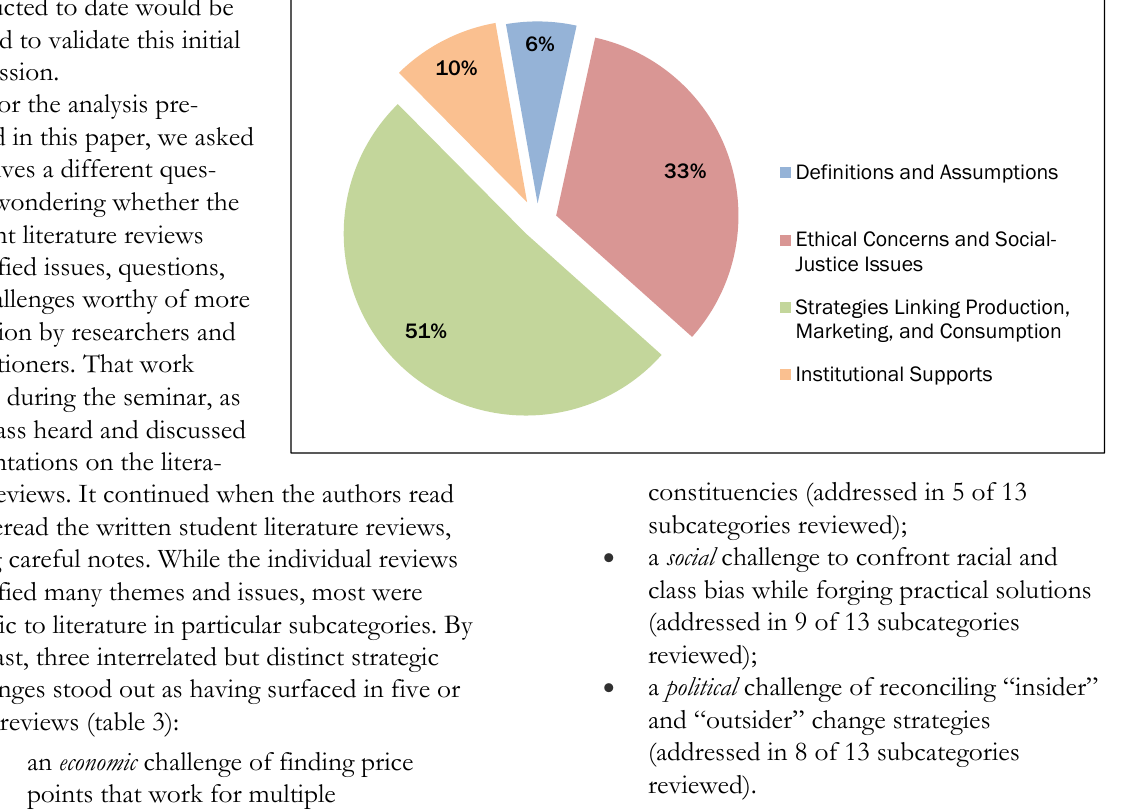
Table 3. Strategic Challenges Identified in Five or More Student Literature Reviews (by subcategories) Subcategory Reviewed Assumptions about constraints and opportunities posed